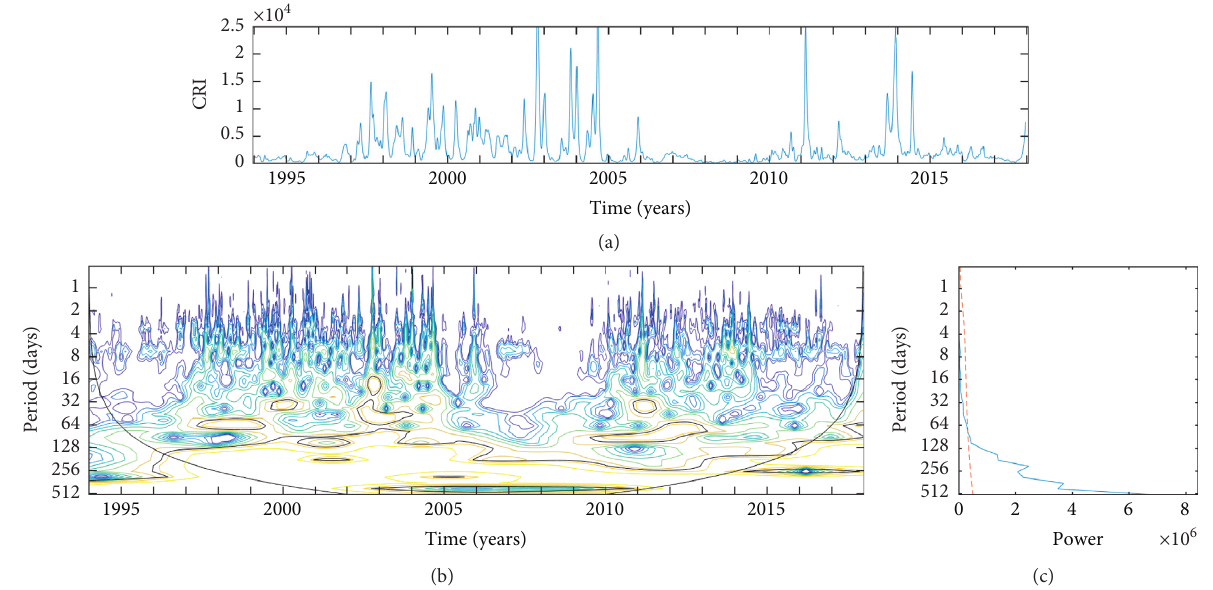
Figure 4: (a) The scale-average time series of daily cosmic ray intensity, (b) the wavelet spectrum, and (c) the global wavelet spectrum. For more details see the